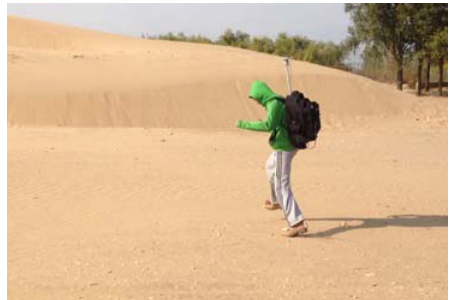
Figure 7. Field experiments in a desert